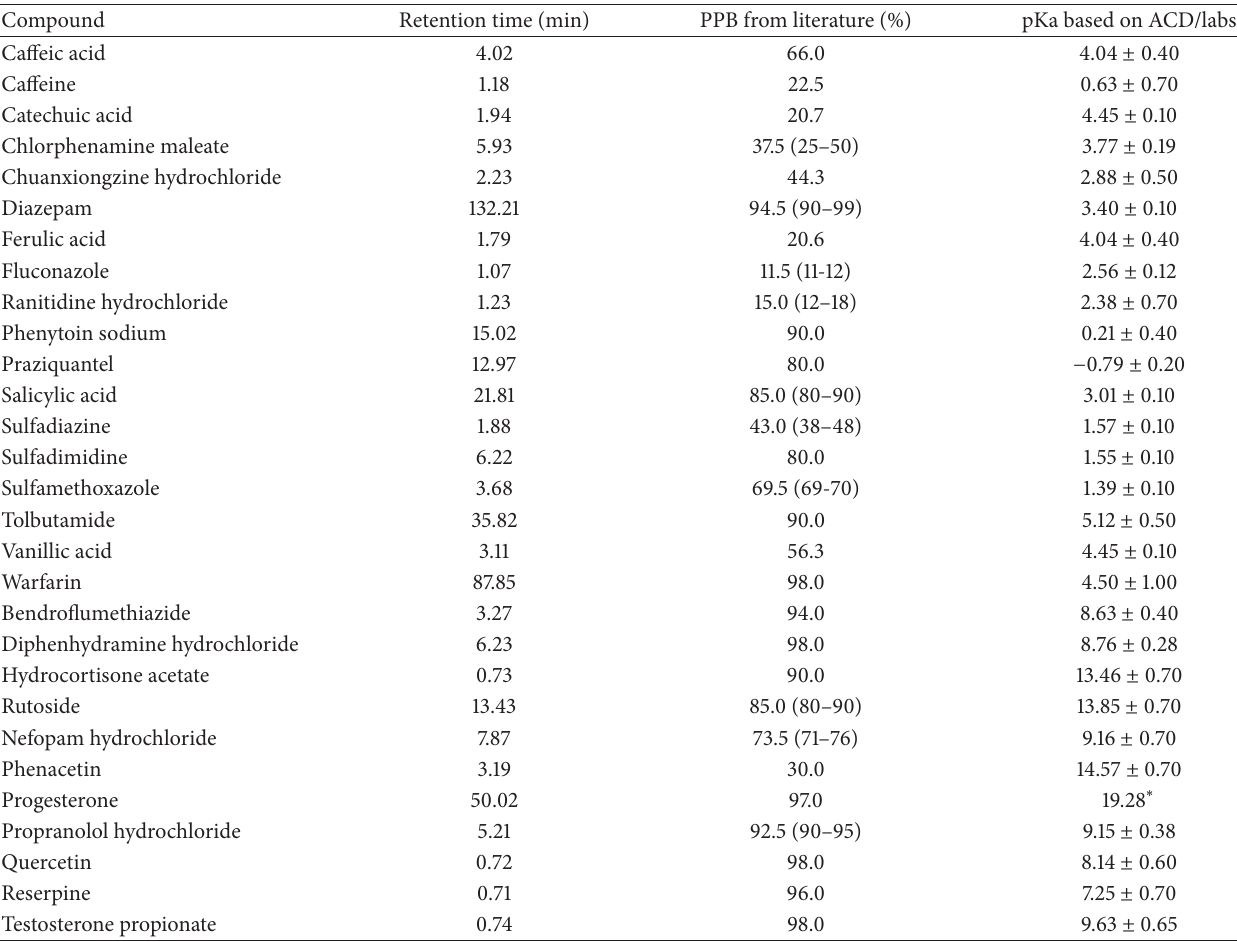
Table 1: The retention time, reported PPB, and predicted pKa of reference compounds.